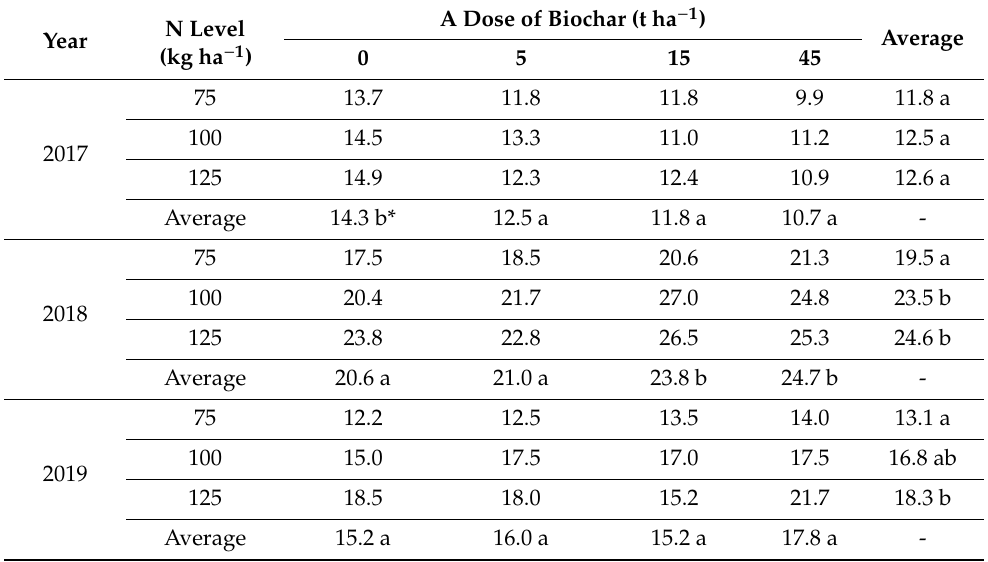
Table 3. Interaction of experimental factors (year, dose of biochar, and dose of fertilizing nitrogen) on the yield of peppermint herb (t of fresh matter ha − 1